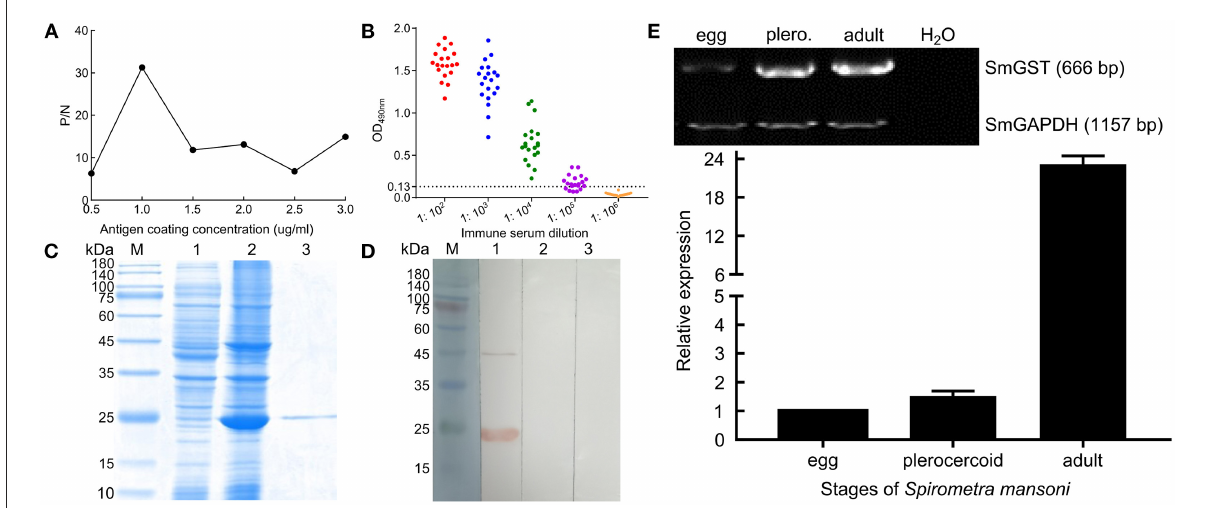
FIGURE2 Molecular characterization of cloned SmGST. (A) Determination of optimal antigen coating concentration. (B) Determination of anti-rSmGST immune serum titer by indirect ELISA. Red, blue, green, purple, and orange represent serum dilutions of 1:10 2 , 1:10 3 , 1:10 4 , 1:10 5 , and 1:10 6 , respectively. (C) SDS-PAGE analysis of 10 µ g purified GST from S. mansoni on 12% gel. M: protein pre-staining marker; Lane 1: uninduced bacterial cultures; Lane 2: the lysate of the induced recombinant bacteria harboring pQE-80L-rSmGST after ultrasonication; Lane 3: